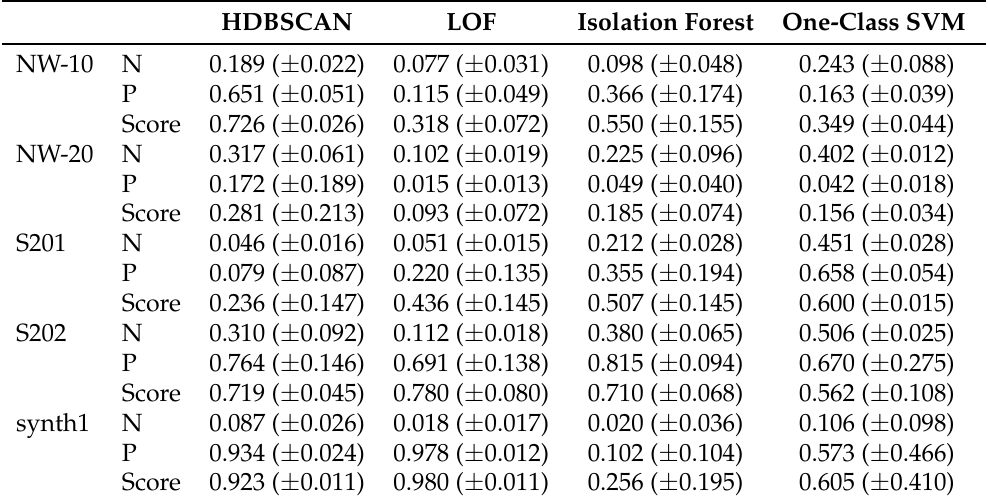
Table 2. Average results of the proposed method with respect to the base model—average of runs for different parameter values, without correction model.